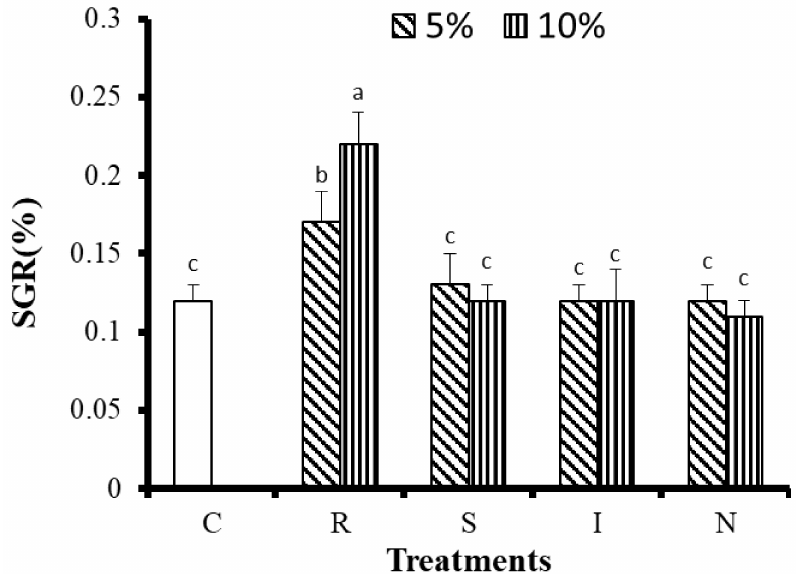
Figure 2. Growth of G. columna after 8 weeks of daily feeding. C: no feeding; R: artificial polyunsat- urated fatty acid (PUFA) rich in animal protein; S: Saccharomyces cerevisiae ; I: Isochrysis galbana tml; N: Nannochloropsis oculata . Different letters indicate significant differences among groups ( p < 0.05). Values are expressed as means ± SDs ( n = 30